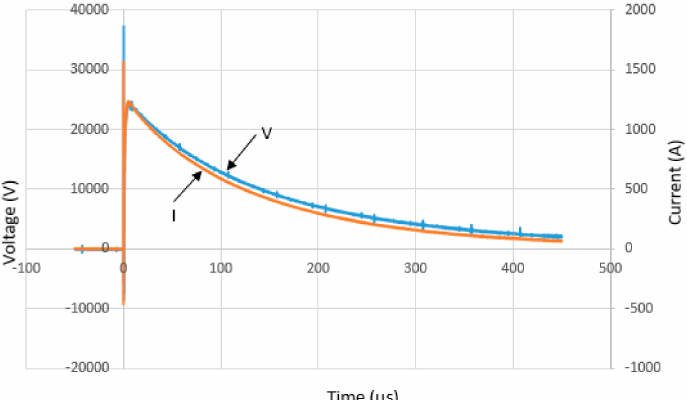
Figure 10. Improved voltage and current traces positive polarity for sample C, at a charging voltage of 50 kV.